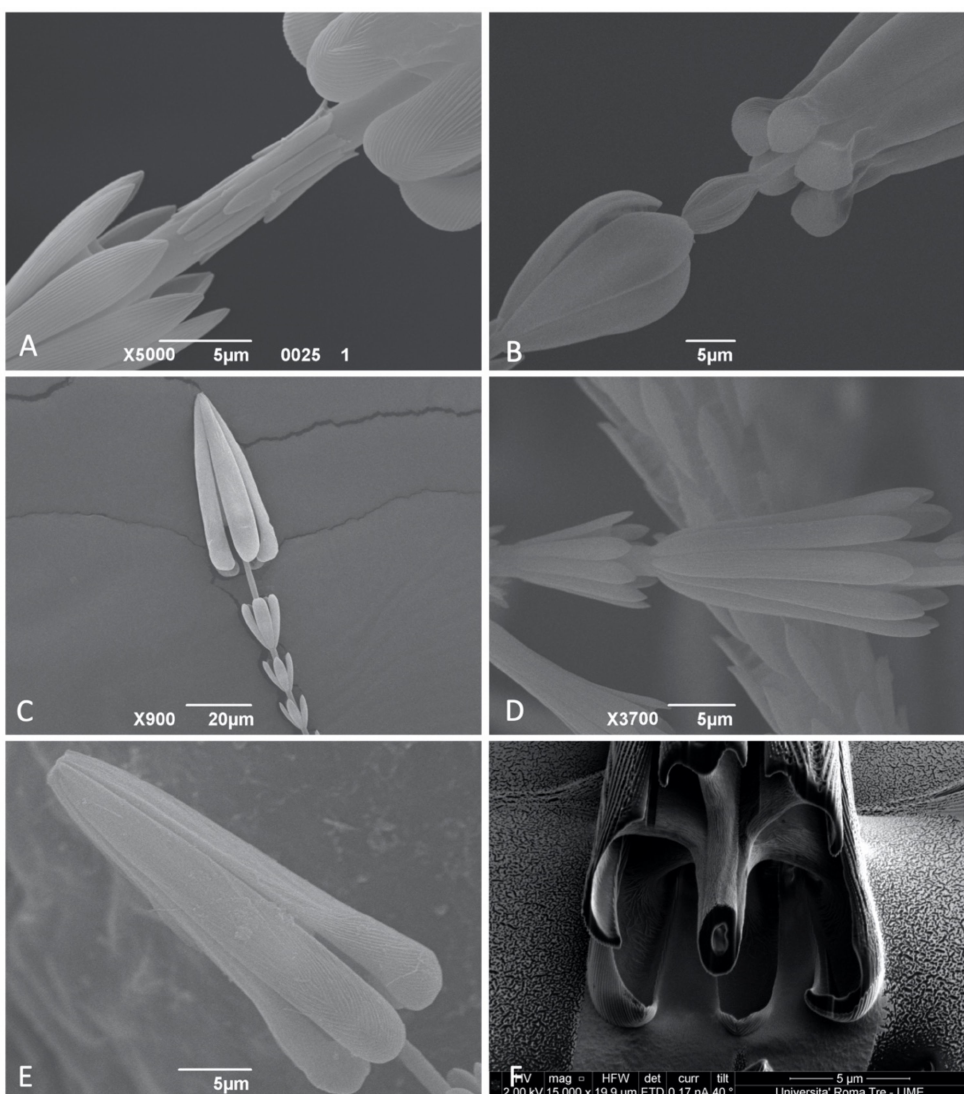
Figure 3. SEM photos of Megatominae larvae: ( A ) Megatoma undata , detail the hastiseta showing the irregular scales on the shaft; ( B ) Ctesias serra , detail of the last rosette and the bud-like modification of the shaft; ( C ) Anthrenus ( Anthrenus ) latefasciatus , hastiseta from the caudal tufts, detail of the apical part; ( D ) Thaumaglossa rufocapillata , size and shape comparison between the penultimate and ultimate rosette; ( E ) Anthrenus ( Florilinus ) olgae ; head of hastiseta; ( F ) Diagonal section of the basal part of the head of the hastiseta of Trogoderma variabile